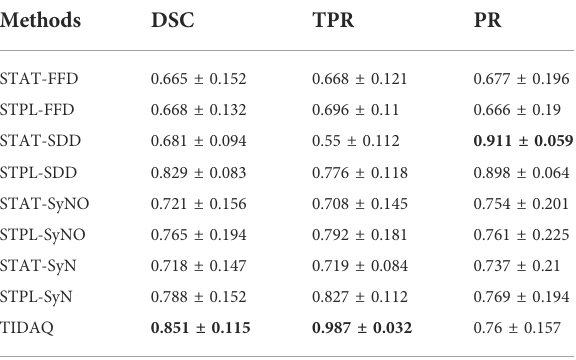
TABLE 8 66% Cortical Bone Segmentation Performance (mean ± standard deviation). DSC: Dice Similarity Coef fi cient, TPR: True Positive Rate, PR: Precision.